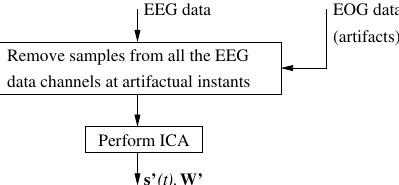
Figure 9. Simple diagram of the process to obtain the unmixing matrix W (cid:48) with diminished influence of artifacts.